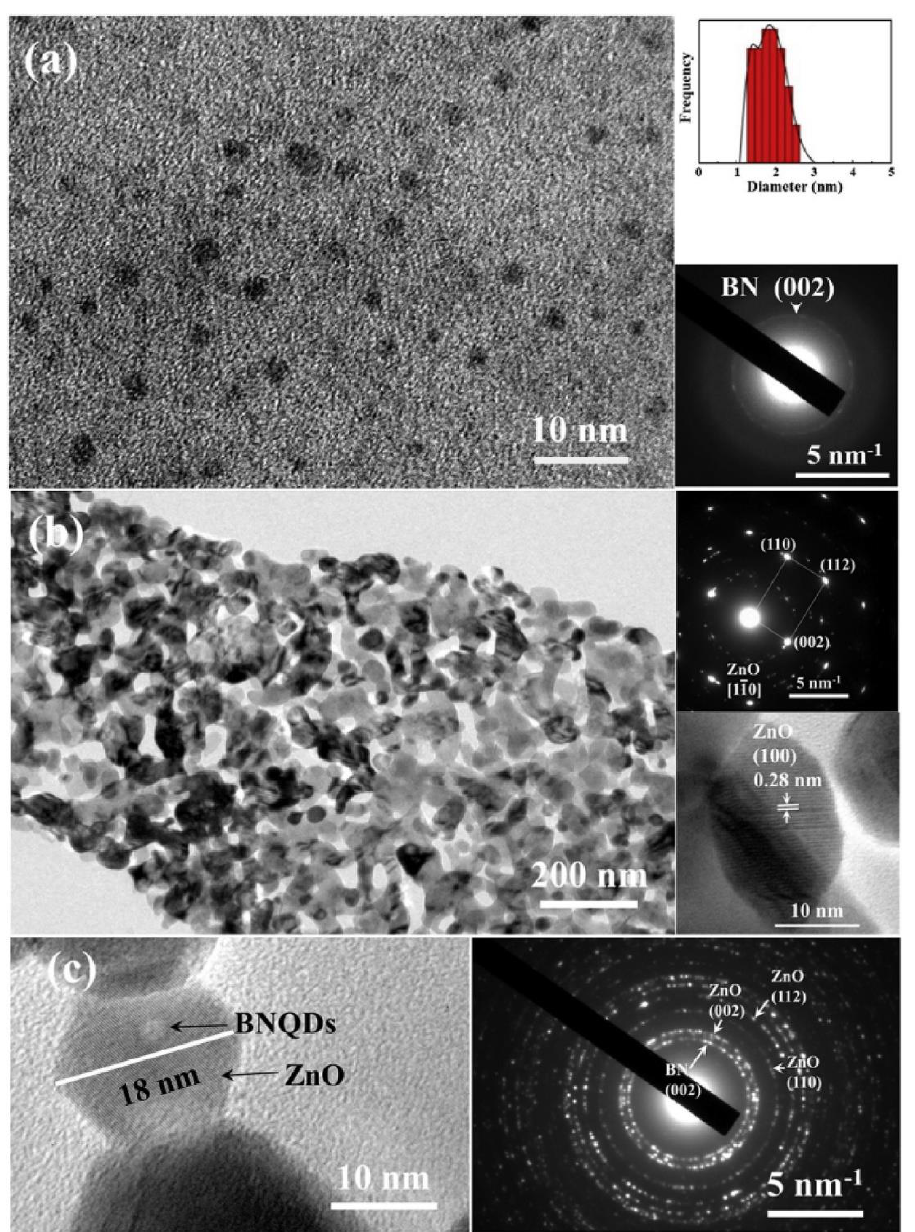
Figure 16. TEM image of ( a ) BN QDs; ( b ) ZnO nanoplates (Insets: Particle size distribution and SAED patterns); ( c ) HRTEM and SAED images of ZnO-BN QDs [126].